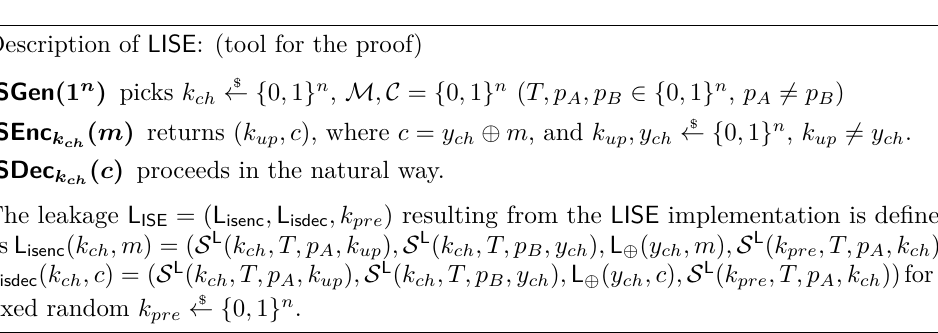
Figure 12: The ideal single-block encryption scheme ISEnc